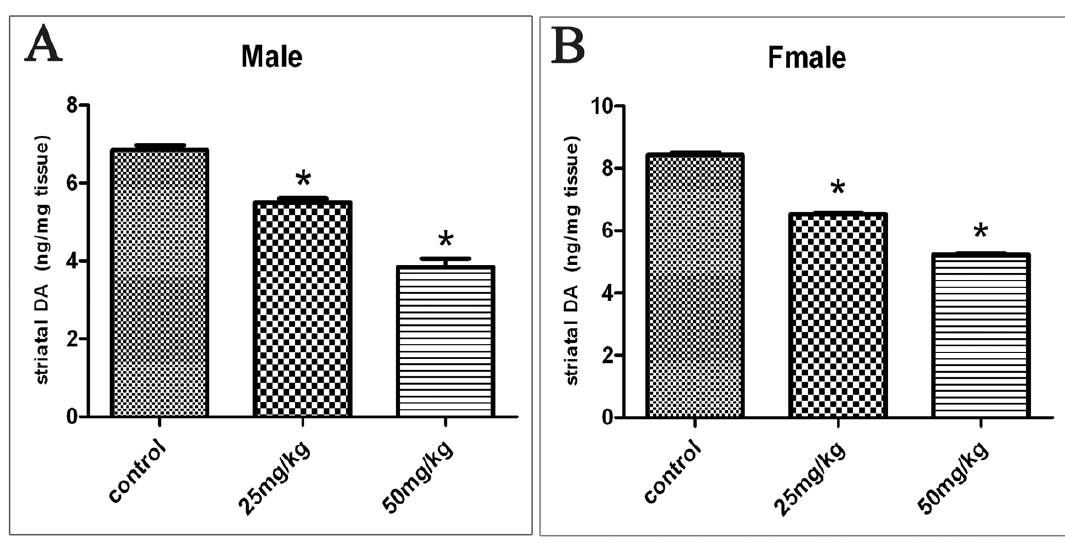
Figure 1. Effects of ATR on the level of DA in the striatum. Values are expressed as the mean ± SD of 10 animals per group. Mean values of DA were, respectively, 6.85, 5.49 and 3.85 ng/mg tissue in males ( A ); 8.43, 6.53, and 5.23 ng/mg tissues in females ( B ). * on top of bars indicates p < 0.05 (compared with the control